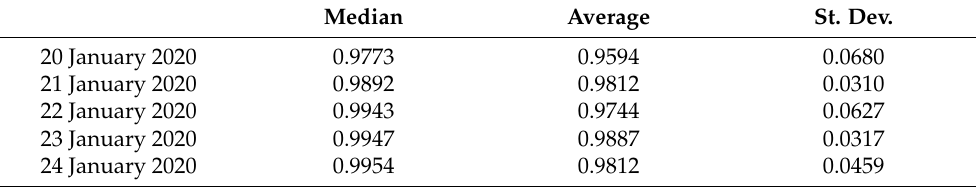
Table 3. Daily statistical parameters for the copolar correlation coefficient: five days in January 2020. Median Average St.